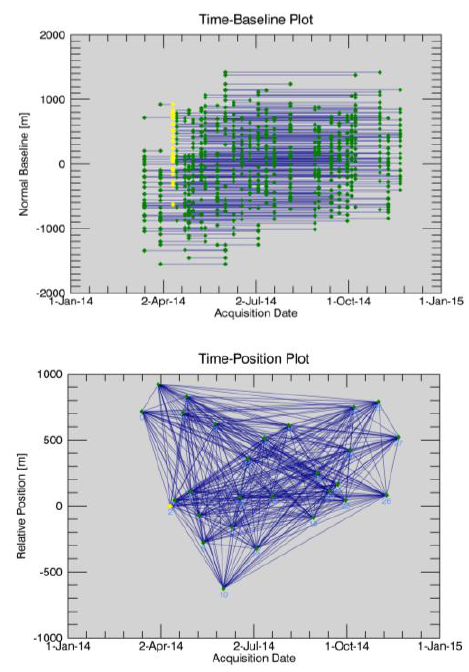
Figure 5. Definition base lines of pictures